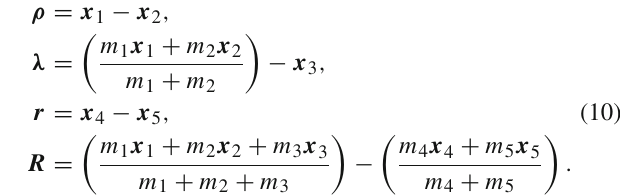
Table 2 The masses of ground-state baryons and mesons (unit: